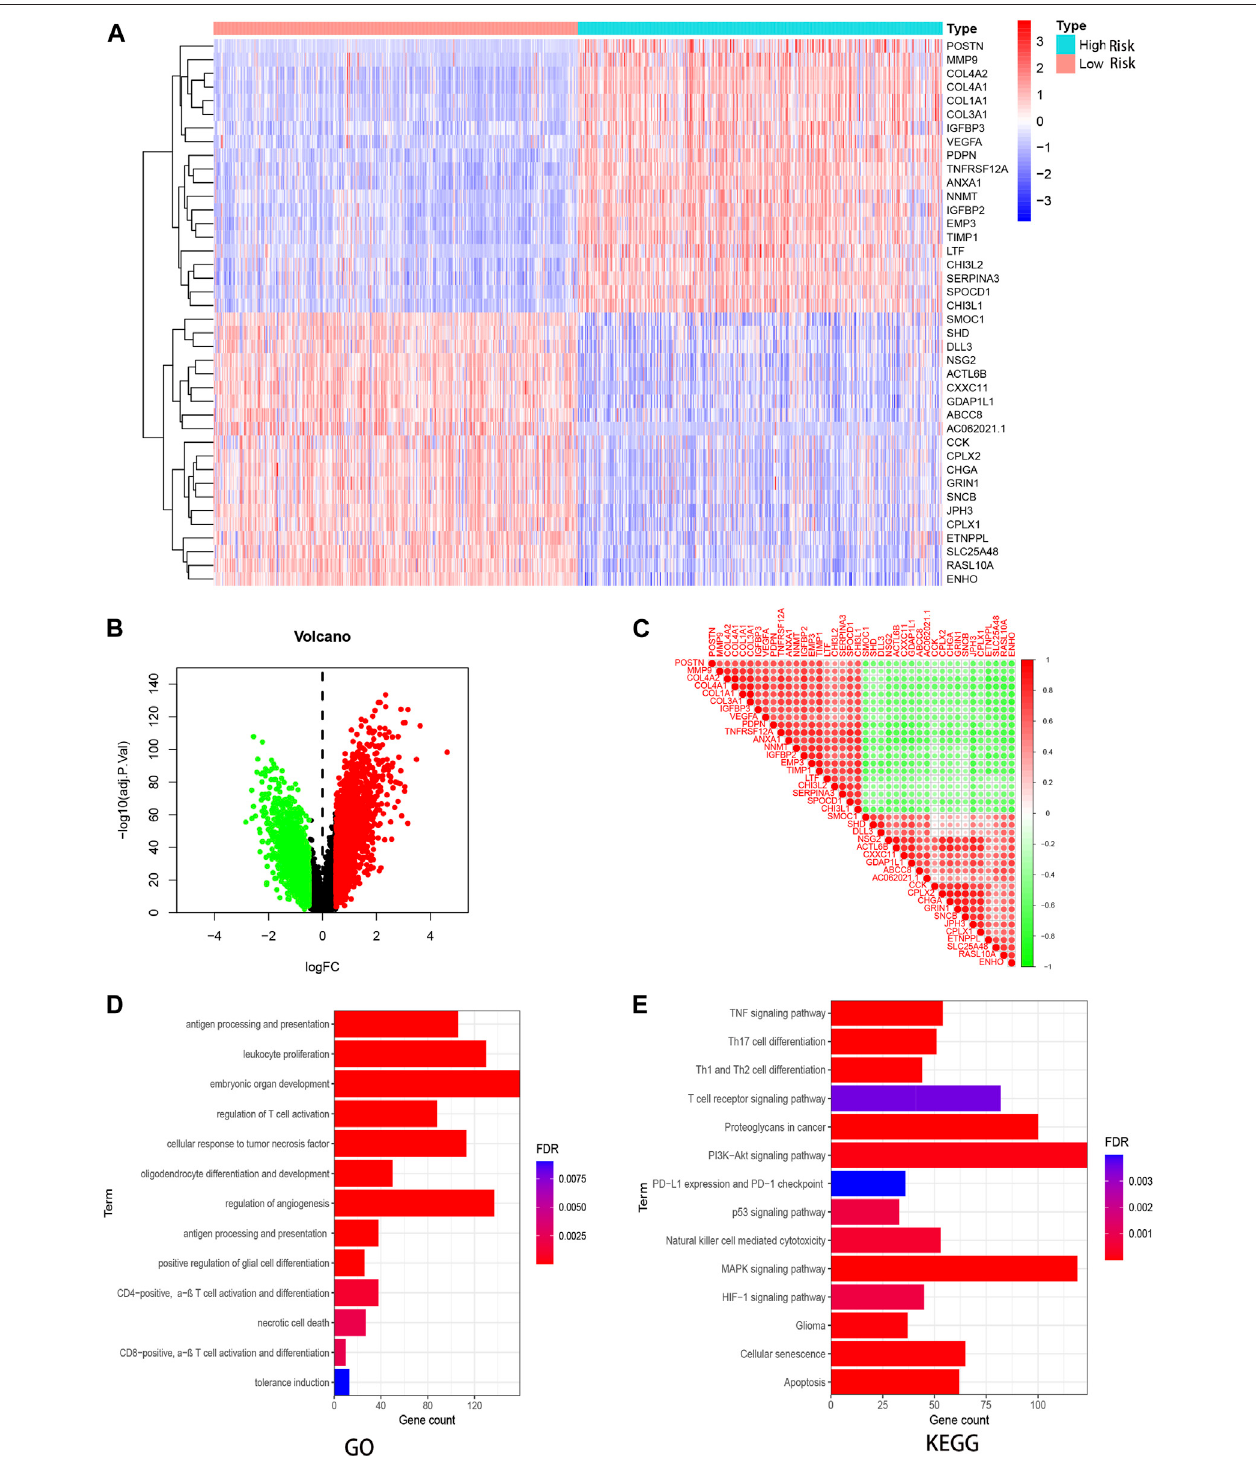
FIGURE6| DEGandenrichmentanalysisforrisksignature. (A) HeatmapforDEGsgeneratedbycomparisonofthehigh-andlow-riskindividuals. (B) Volcanomap of distribution of DEGs. (C) Heatmap of correlations between differential genes. Red circles represent positively correlation, green represents negative. (D,E) GO and KEGG analysis for these DEGs in GBM.